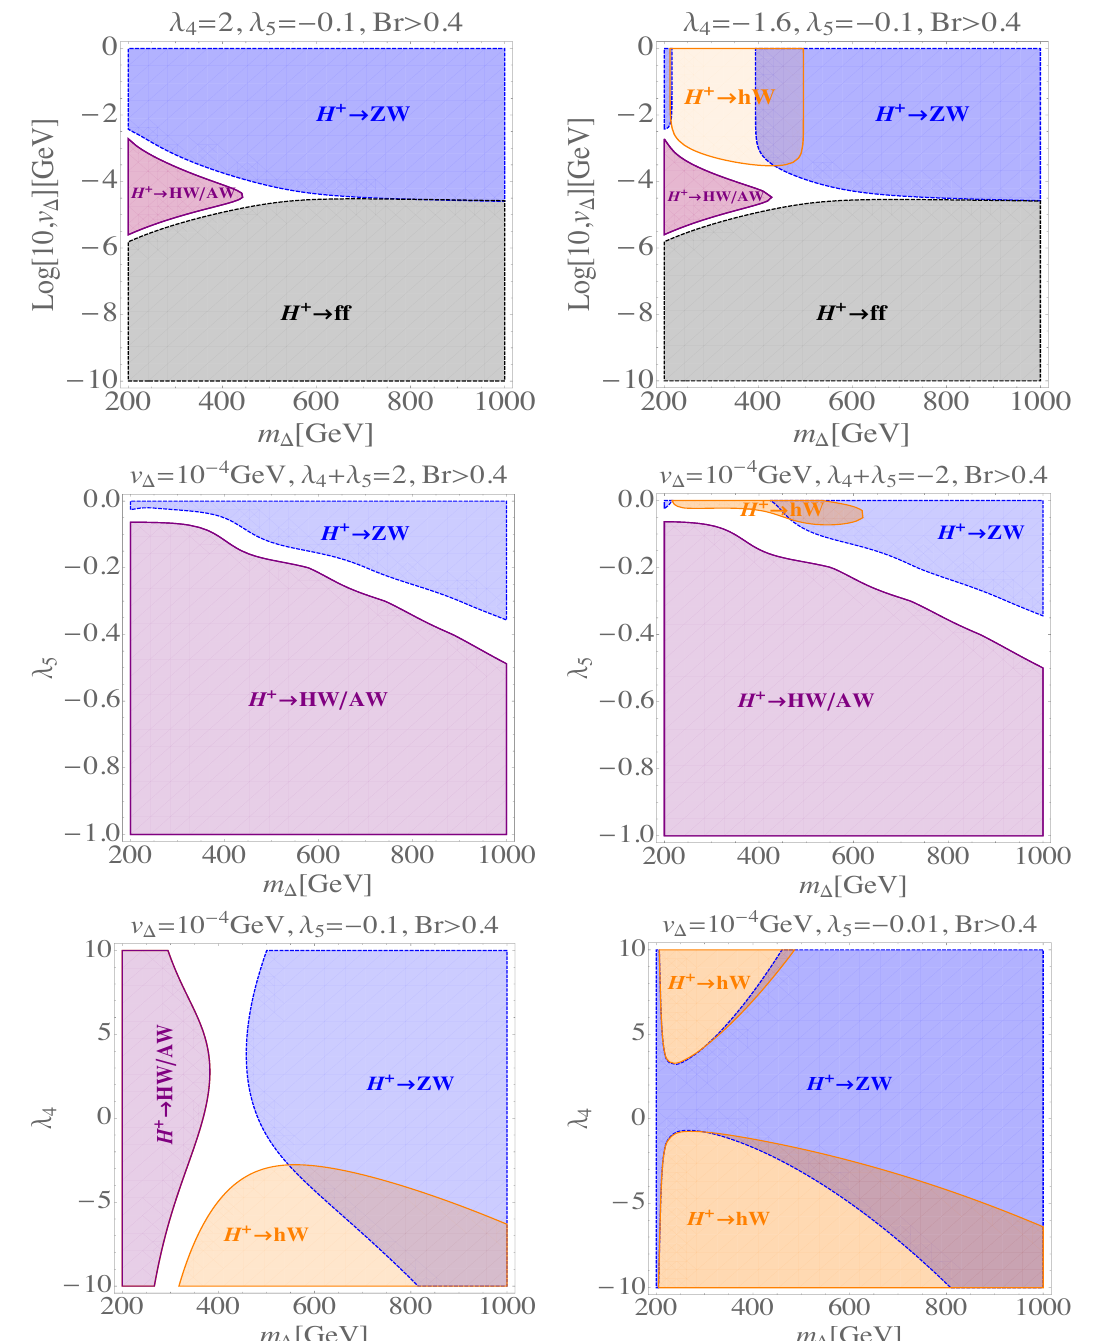
Figure 6 . Decay region plots for H (cid:6) with BR (cid:21) 40%. Purple region is for HW and AW , blue for ZW , orange for hW and black for the lepton (cid:12)nal state. The (cid:12)rst row is with the same (cid:21) 5 but opposite-sign (cid:21) 4 ; the second row is with the same v (cid:1) but opposite-sign (cid:21) 45 and the third row is with the same v (cid:1) but di(cid:11)erent (cid:21) 5 . From those plots we conclude that H (cid:6) ! hW (cid:6) channel prefers (cid:21) 45 < 0 in general. For (cid:21) 5 = (cid:0) 0 : 01, H (cid:6) ! hW (cid:6) also gains a large branching ratio when (cid:21) 4 goes from negative to positive as can be seen from the last graph.